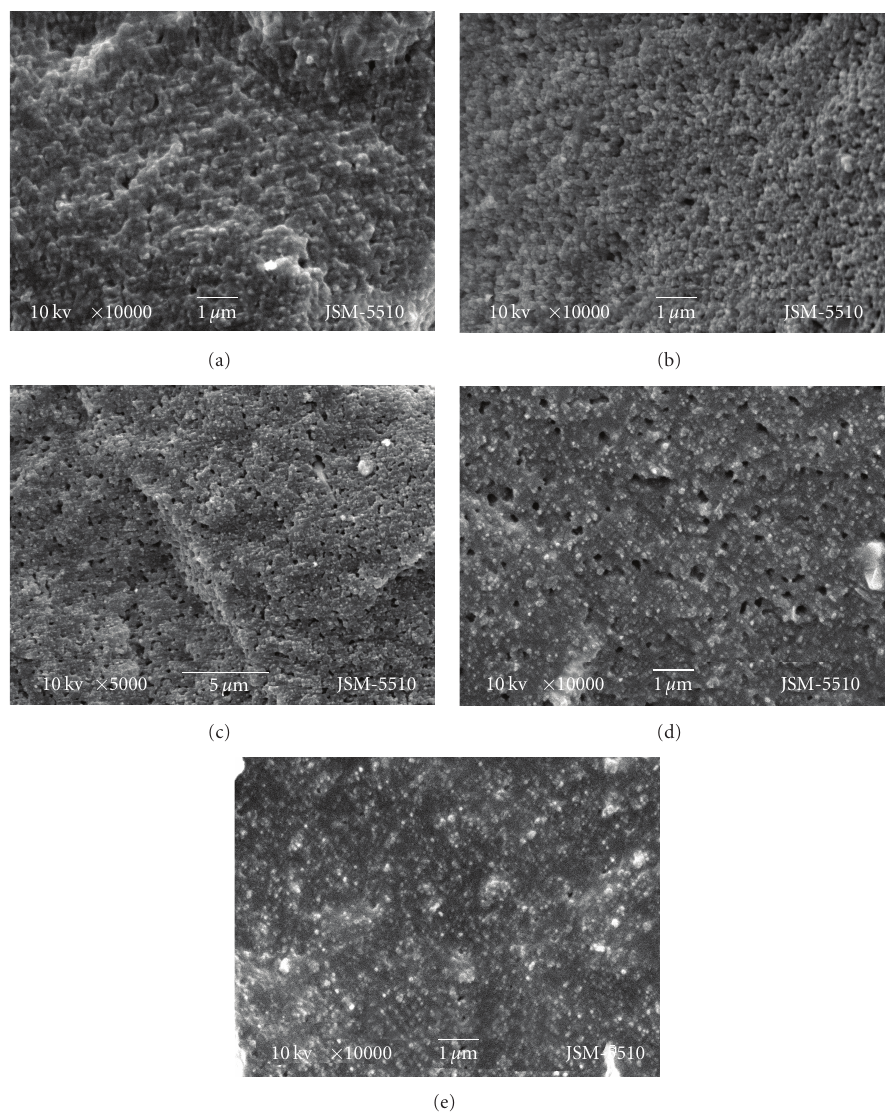
Figure 7: SEM micrographs of vulcanizates, containing di ff erent amounts of fillers: (a) 20 phr of CB Corax N220 ( × 10000); (b) 50phr of CB Corax N220 ( × 10000); (c) 50 phr of CB Corax N220 ( × 5000); (d) 10phr of Printex XE-2B ( × 10000); (e) 20phr of Printex XE-2B( ×